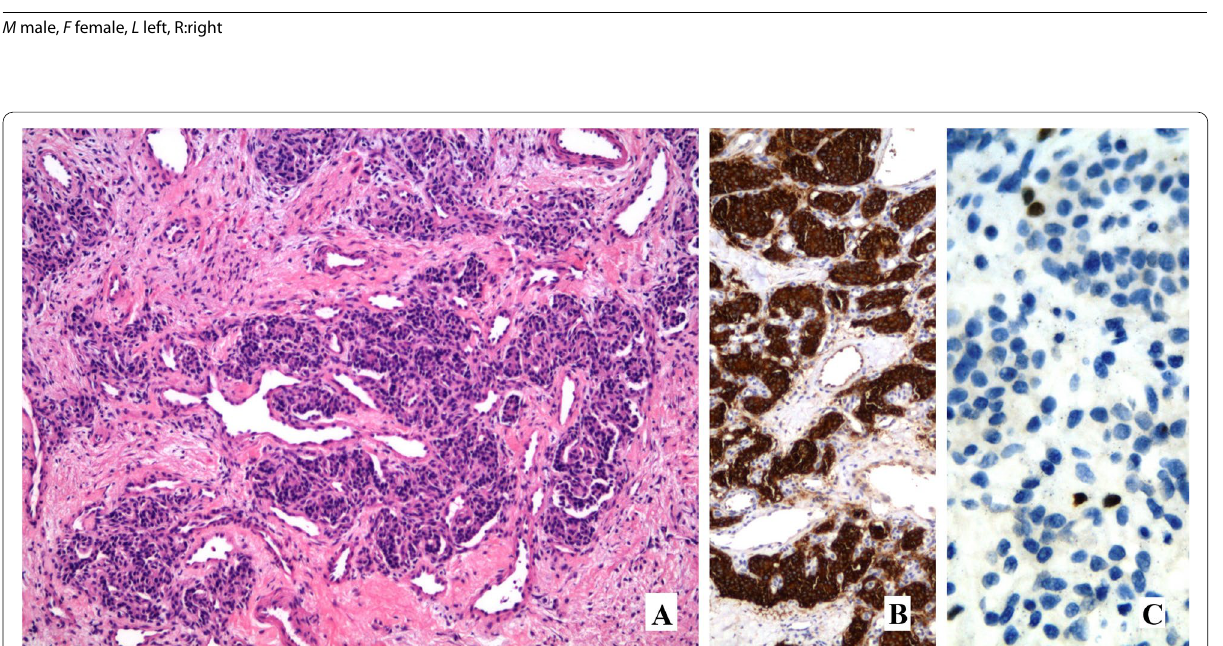
M male, F female, L left, R:right